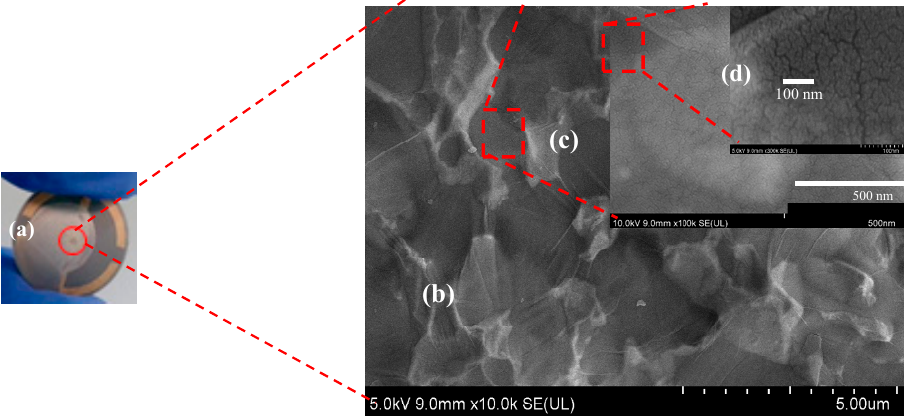
Figure 3. Photograph of as-fabricated Pt-GO-LCM sensor ( a ) and FESEM images obtained from the central Au electrode region of the device at 10000 × ( b ), 100000 × ( c ), and 3000000 × ( d ) magnifications.